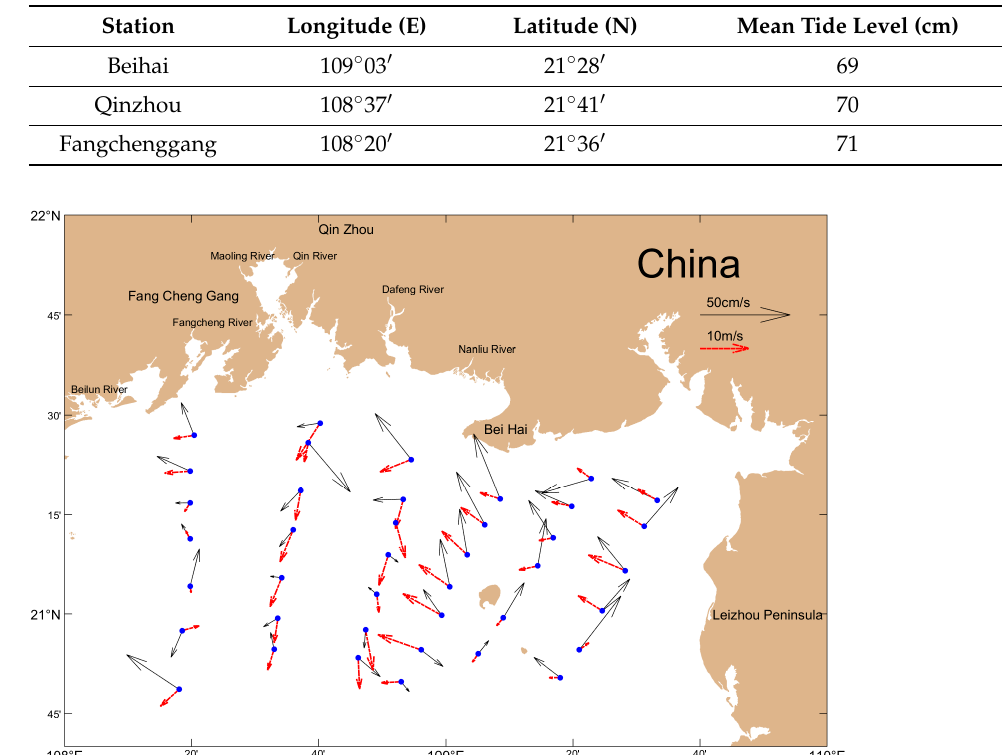
Figure 3. Distribution of currents (black arrows) and wind fields (red dashed arrows) during the sampling period in May 2021. sampling period in May Table 1. Mean sea level at Beihai, Qinzhou, and Fangchenggang stations (unit: cm, reference datum: 85).